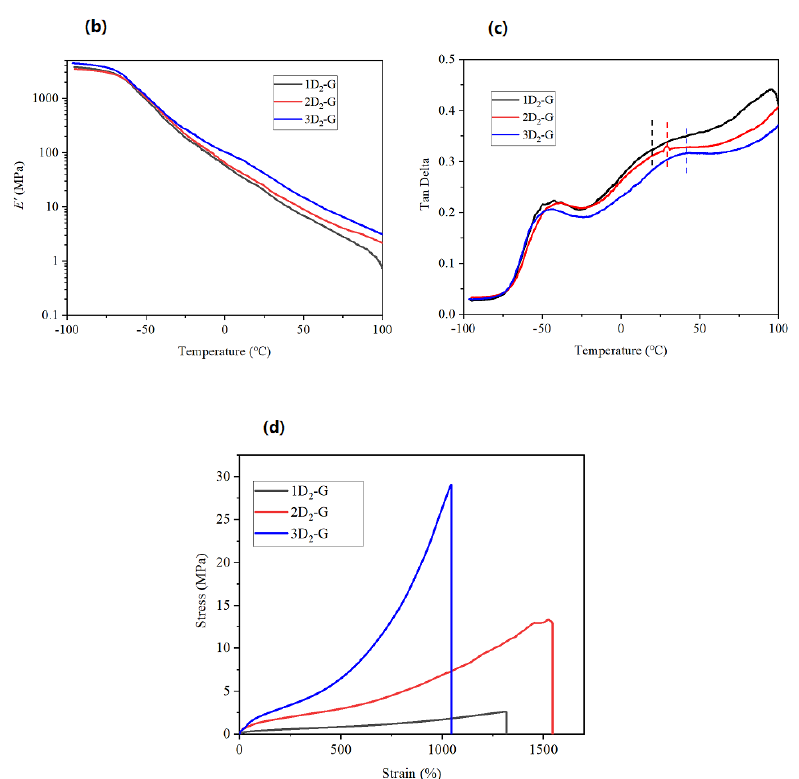
Figure 4. The comparison of 1D 2 -G, 2D 2 -G, and 3D 2 -G. ( a ) FTIR spectral peak fit in the carbonyl region (1800 to 1600 cm − 1 ). ( b ) DMA spectra of storage modulus ( E’ ) vs. temperature. ( c ) DMA spectra of tan δ vs. temperature. ( d ) Tensile stress–strain curve.